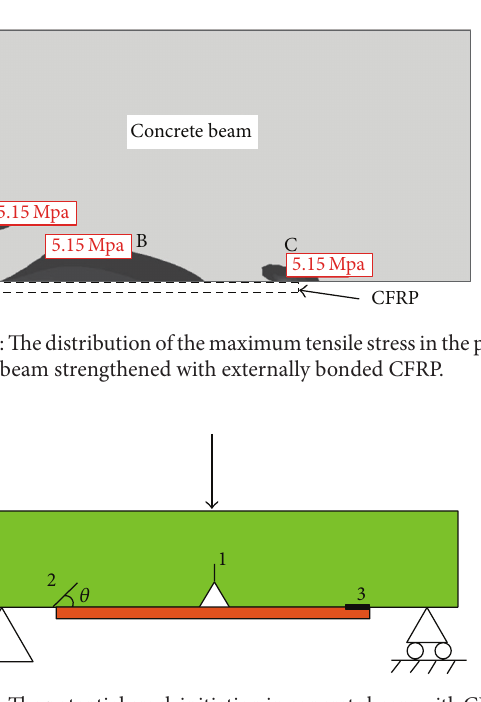
Figure9:ThepotentialcrackinitiationinconcretebeamwithCFRP.